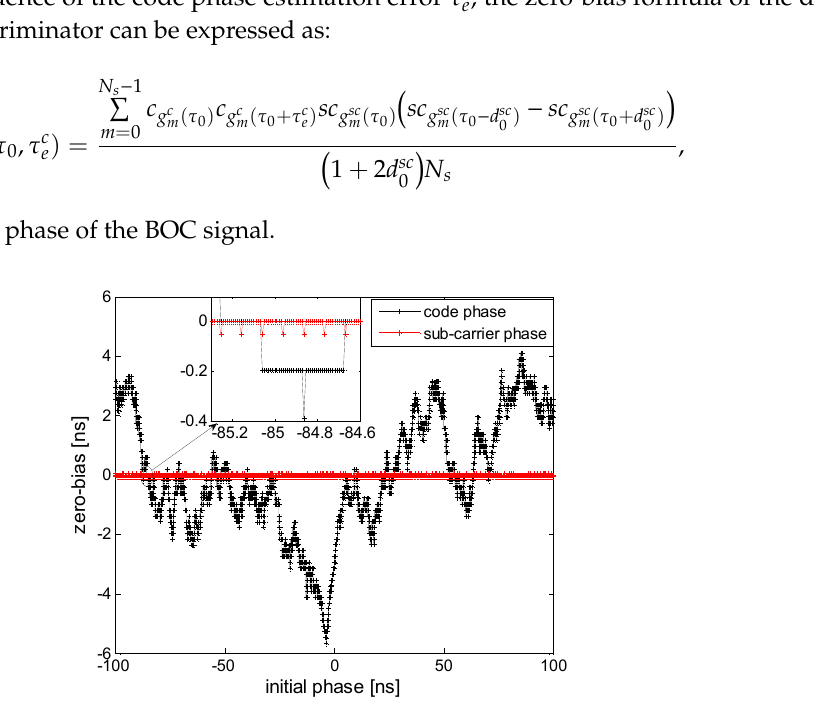
Figure 2. Schematic diagram of resolution error and zero-bias of the digital discriminator of the BOCs (1, 1) signal.